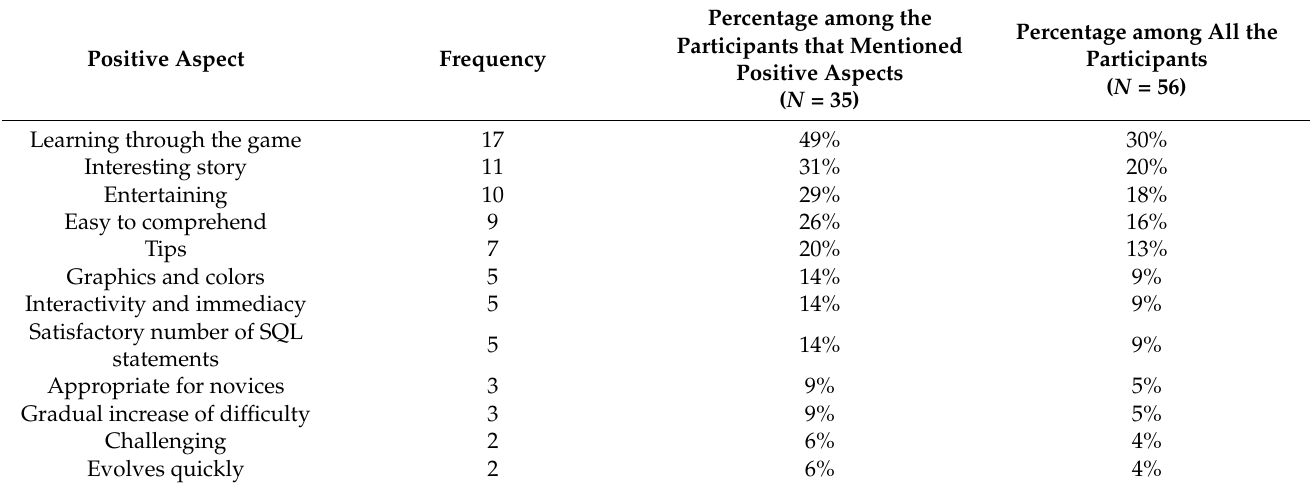
Table 6. Positive aspects of SQL